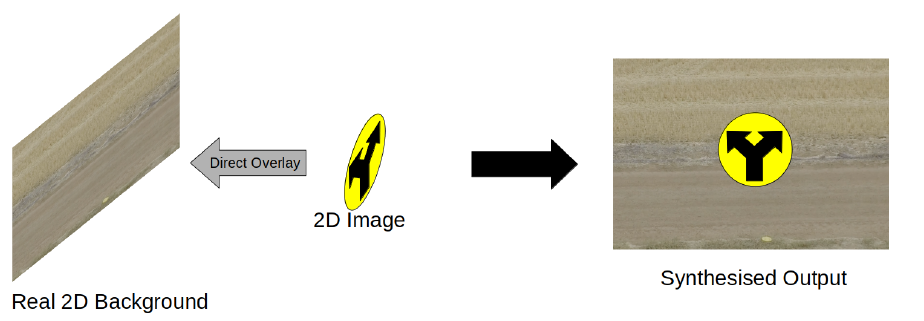
Figure 2. Synthesis via overlaying 2D image onto real 2D